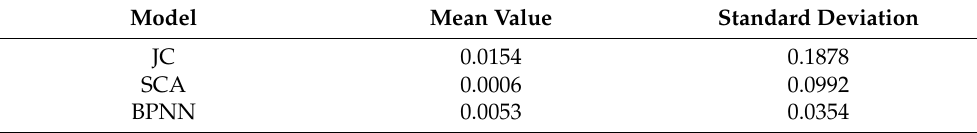
Figure 10. The relative frequency of RE from ( a ) JC model; ( b ) SCA model; ( c ) BPNN model. Table 2. The mean value and standard deviation of RE for the three models.